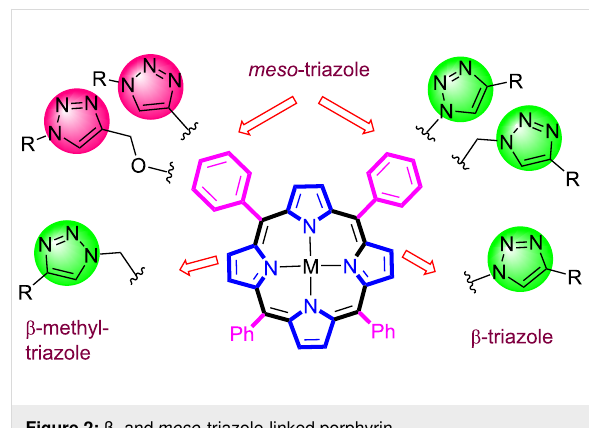
Figure 2: β - and meso -triazole-linked